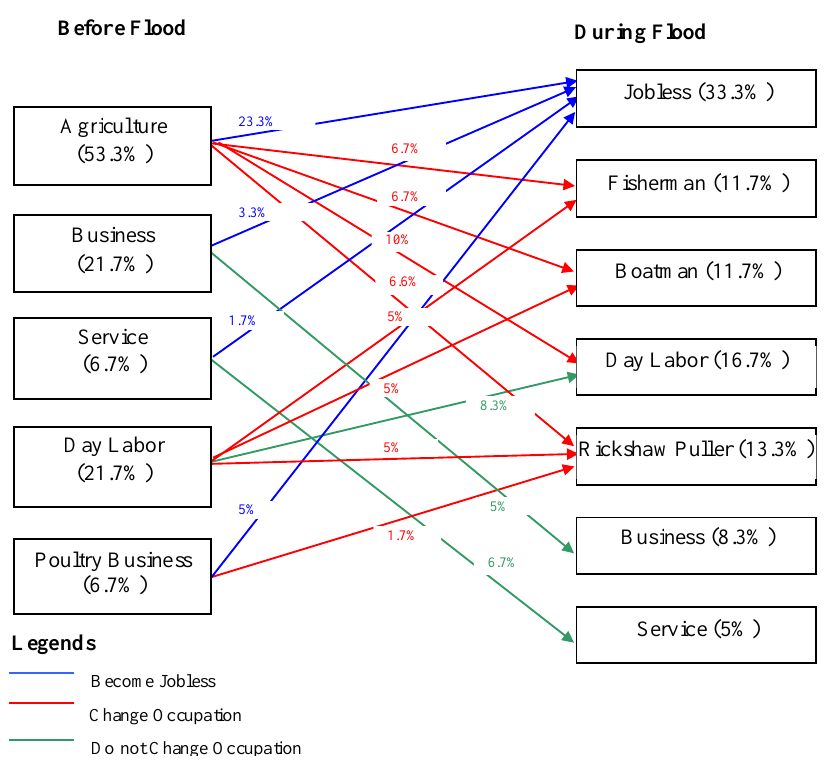
Figure 3. Shifting of occupation due to floods. Source: field survey. Table 2. Distribution of households according to